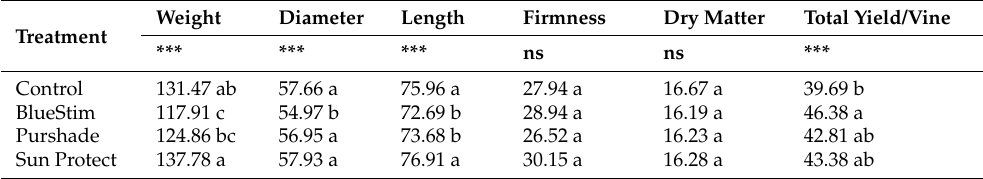
Table 1. Alleviating products’ application effect on kiwifruit mean weight (g), diameter (mm), length (mm), firmness (N), dry matter percentage (%), and total yield per vine (Kg) at harvest.